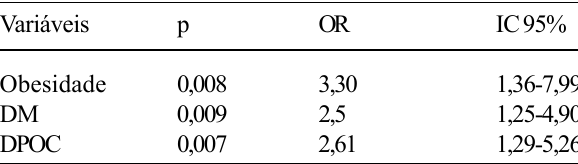
Tabela 2. Análise